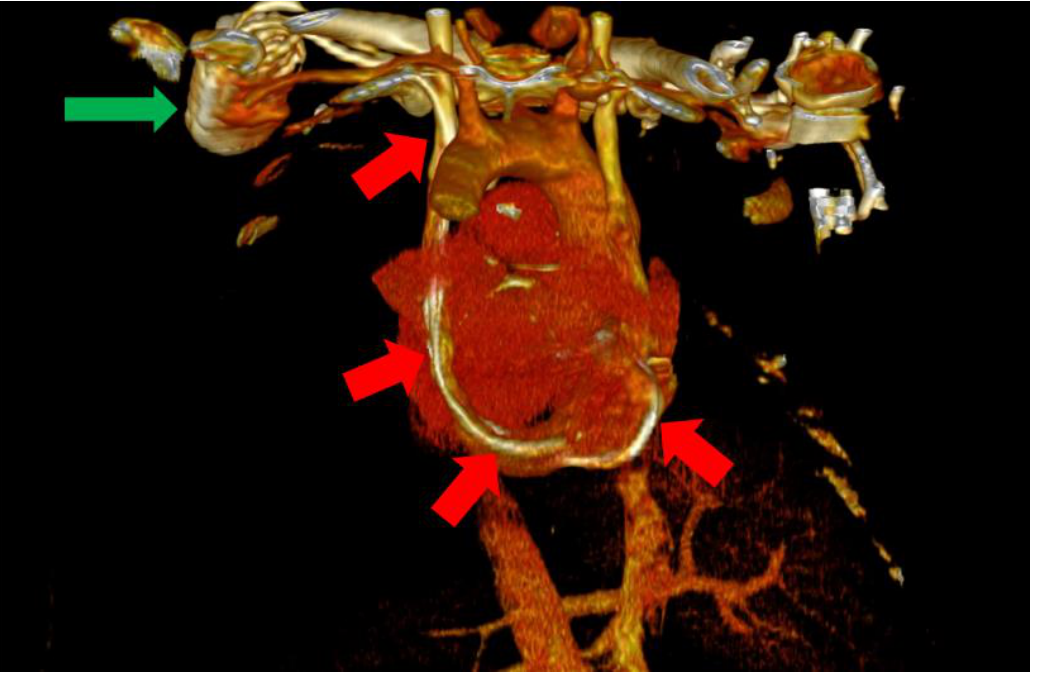
Figure 4. Posterior view of the heart and large vessels with most of the skeletal structure and soft tissue removed. The impulse generator (green arrow) and the leads can be clearly observed through the PLSVC (red arrows).